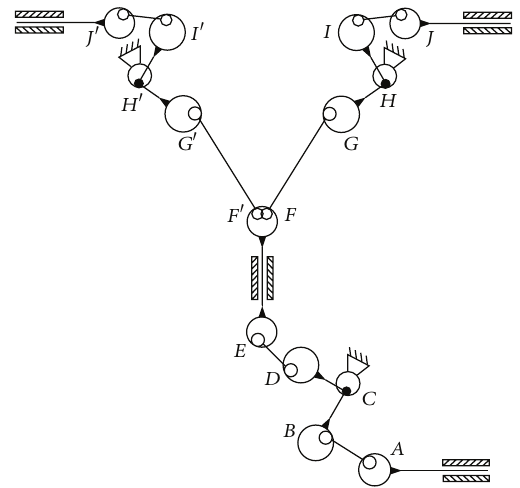
Figure 2: Schematic diagram of the transmission mechanism with multiclearance joints.